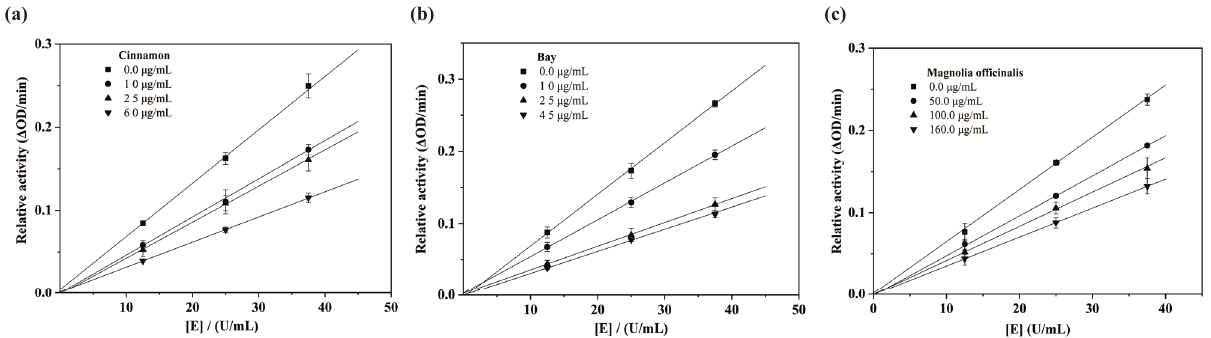
Fig. 1. The inhibitory mechanism of cinnamon, bay, and magnolia officinalis against